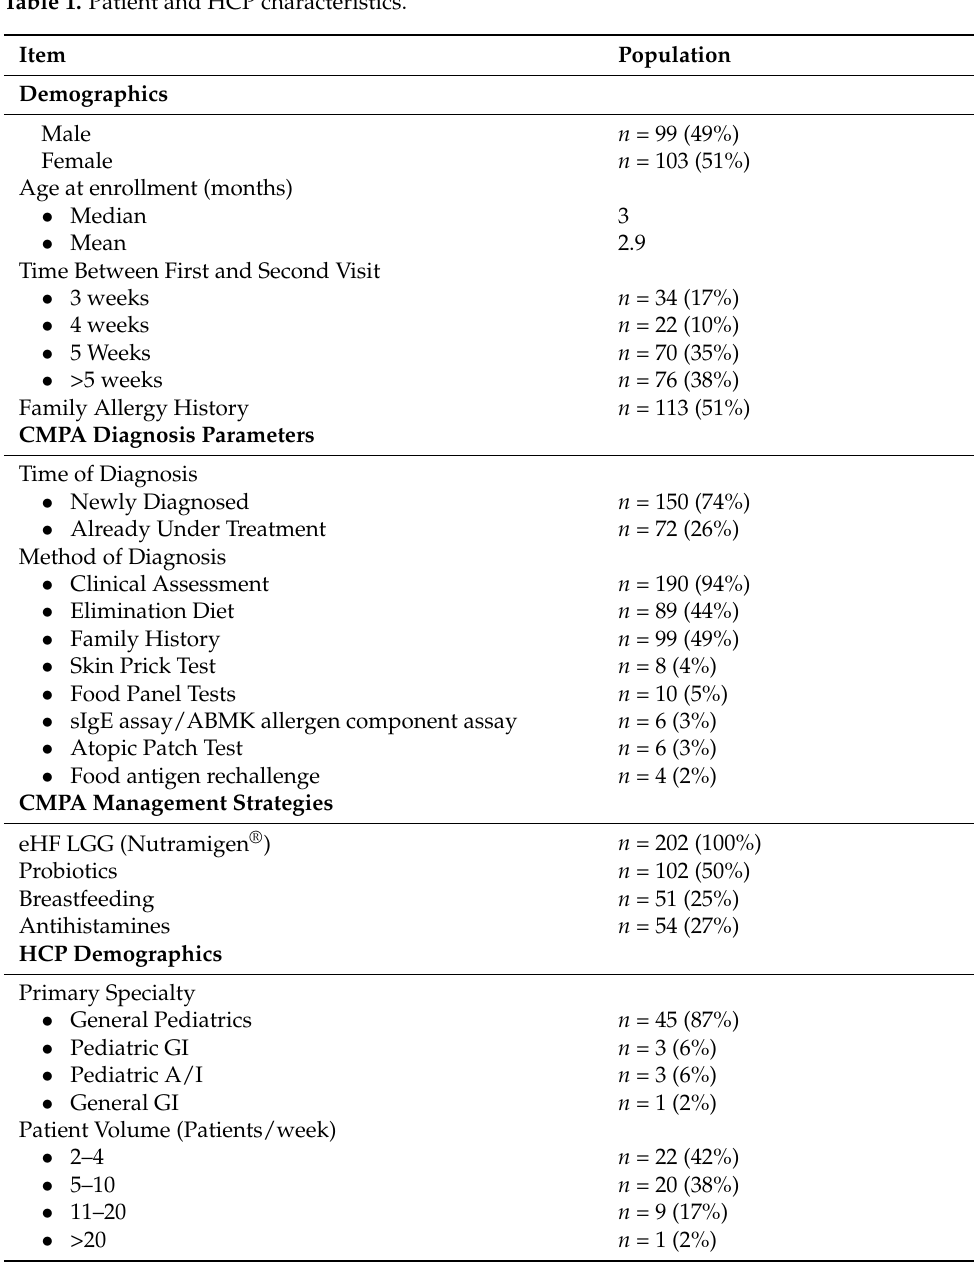
Table 1. Patient and HCP